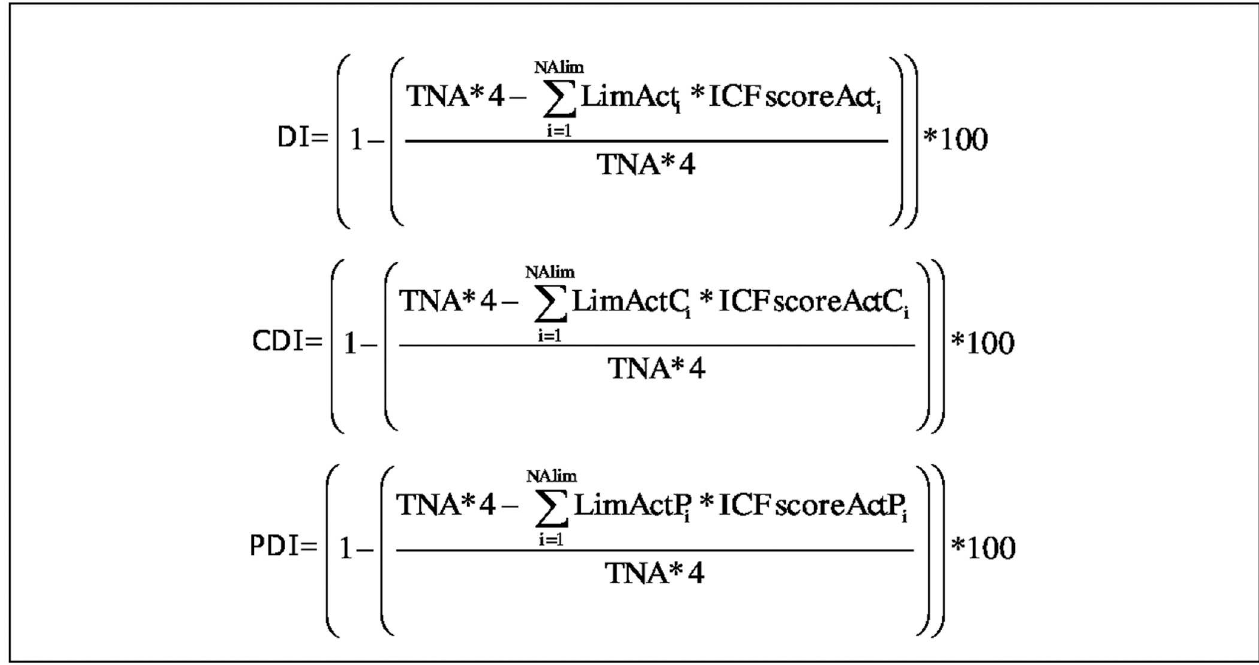
Fig 1. Formulas to calculate the indices of both b- and i-ADL. TNA = Total Number of Activities; LimAct i = the i-th total number of Limited Activities; LimActC i = the i-th total number of LimitedActivities becauseof a Cognitivereason; LimActP i = the i-th total number of LimitedActivities becauseof a Physical reason; ICFscoreActi = the performancescore given to the i-th limited activity; ICFscoreActC i = the performancescore given to the i-th limited activity with a Cognitivereason of limitation; ICFscoreActP i = the performancescore given to the i-th limited activity with a Physical reasonof limitation; TNA * 4= Maximal disability; disability becauseof cognitivereasons;